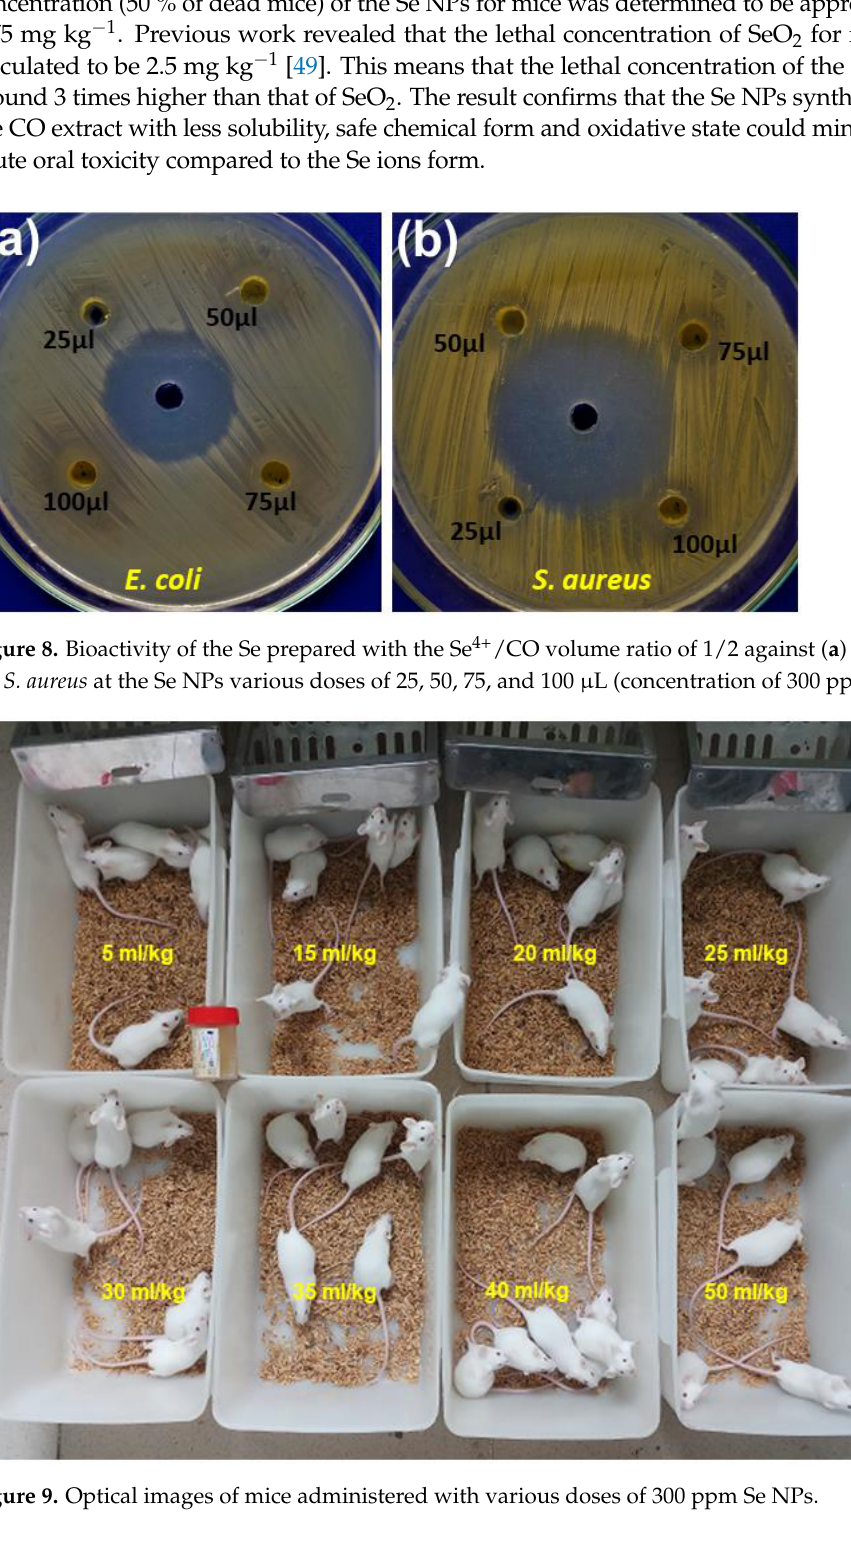
Figure 7. FTIR spectrum of the Se NPs prepared with the Se 4+ /CO volume ratio of 1/2.